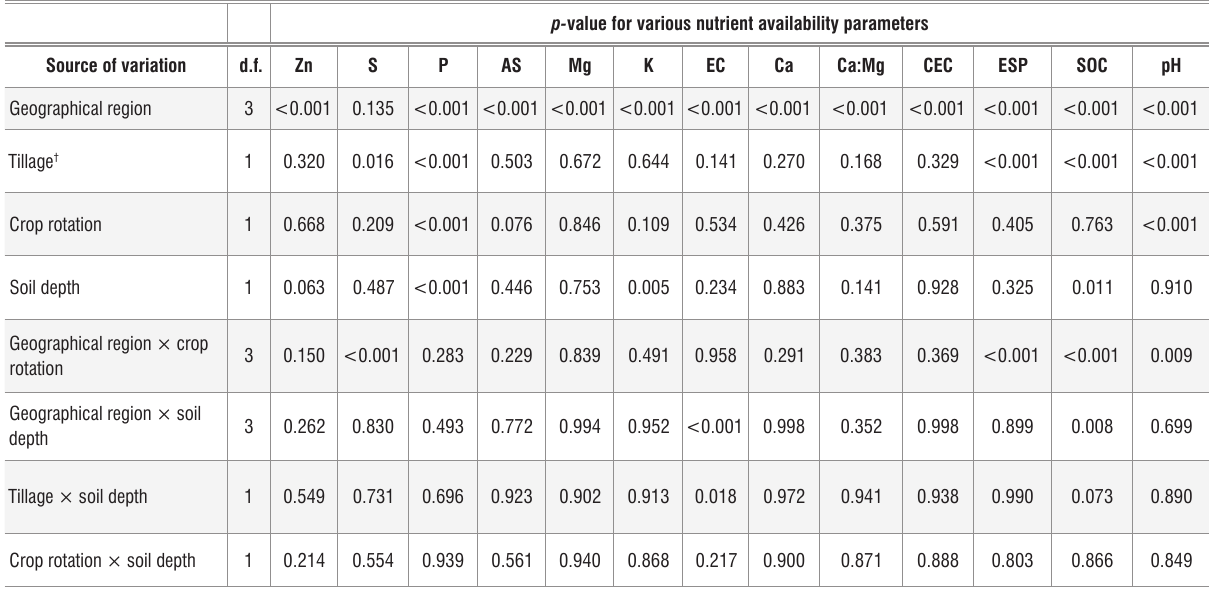
Significance of the fixed effects tested by chi-squared F-statistic (Wald statistic/d.f.) values in the overall REML analysis for the soil fertility parameters pH, Mg, K, P, S, Zn, Ca:Mg ratio, CEC, EC, ESP and SOC of irrigation wheat fields in South Africa p- value for various nutrient availability parameters Source of variation